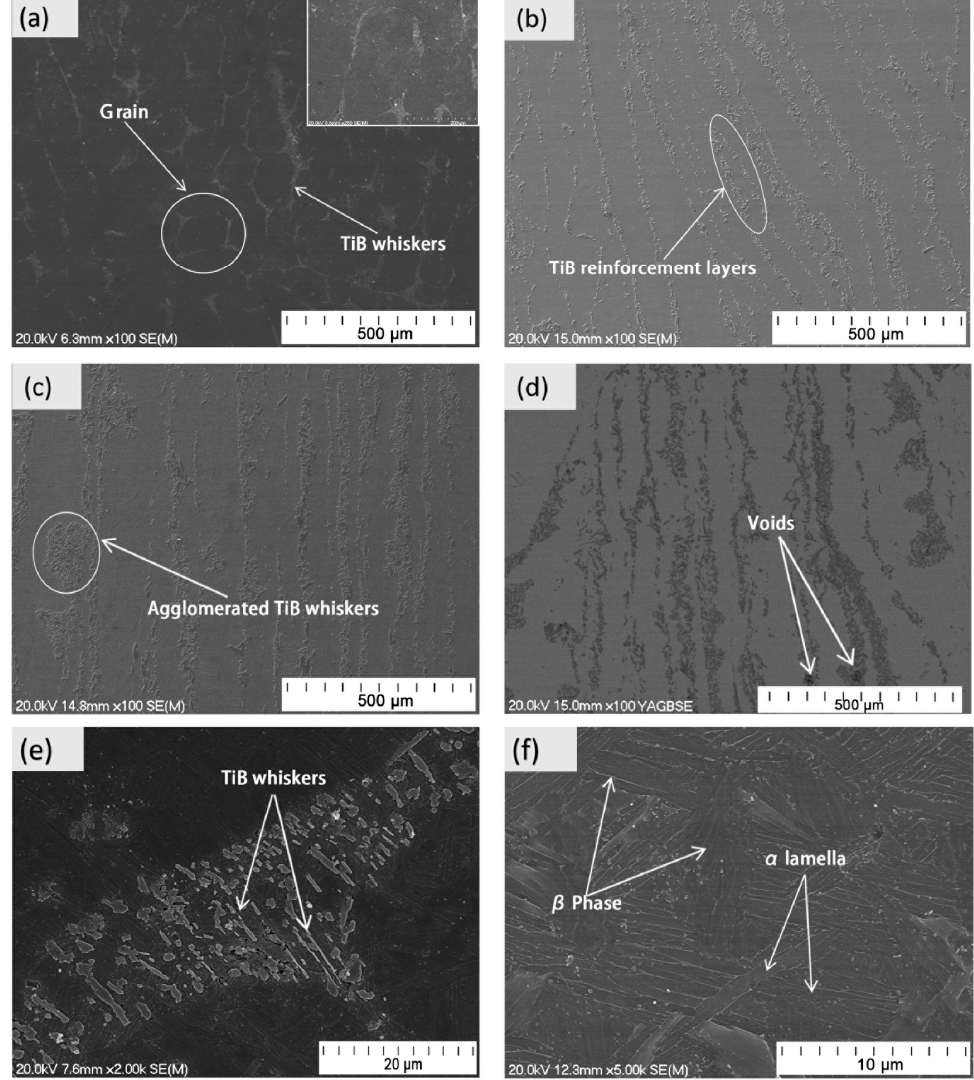
Figure 7. SEM images of Chips-Ti64-xTiB composites: ( a ) Chips-Ti64-1TiB; ( b ) Chips-Ti64-3TiB; ( c ) Chips-Ti64-5TiB; ( d ) Chips-Ti64-7TiB; ( e ) TiB reinforcement from Chips-Ti64-1TiB; and ( f ) matrix phase (Ti-6Al-4V) from Chips-Ti-64-3TiB.